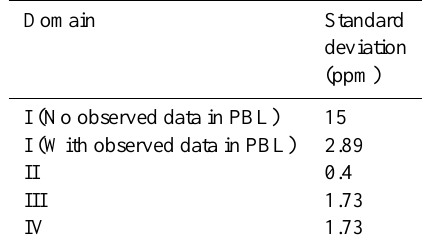
Table 2. The assumed standard deviations of partial XCO 2 in each